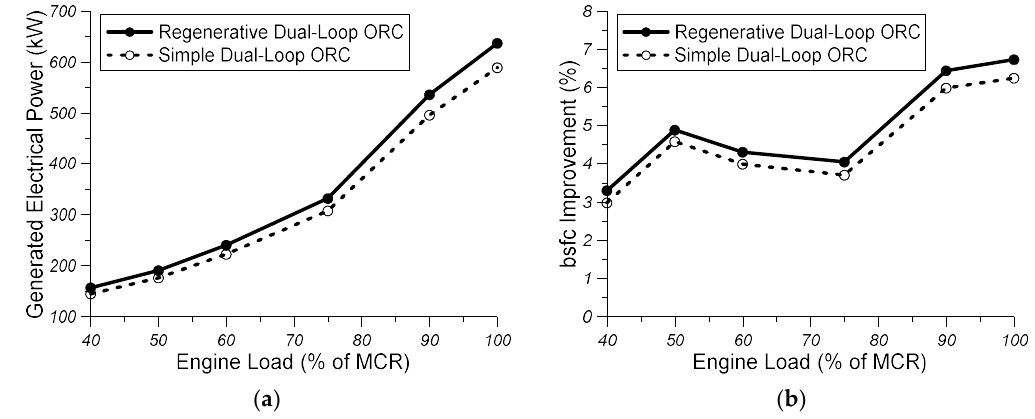
Figure 19. Comparison of ( a ) generated electric power and ( b ) bsfc improvement between the simple dual-loop ORC and the regenerative dual-loop ORC.